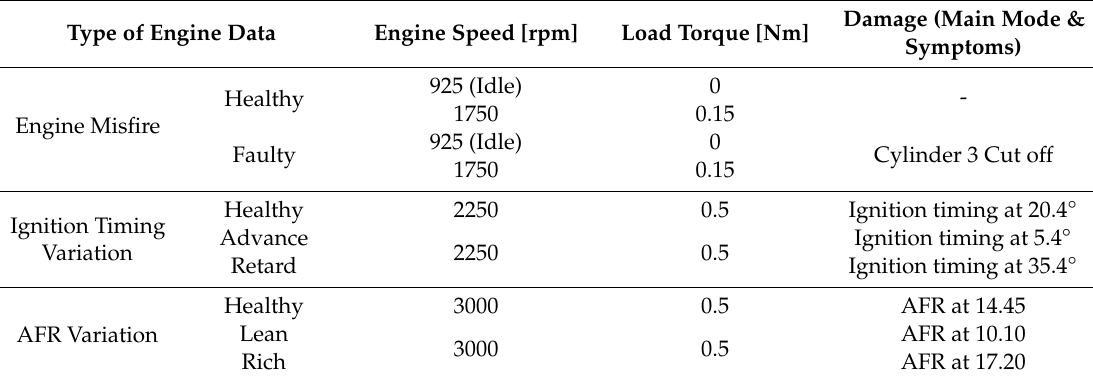
Table 2. Fault seeding and operating